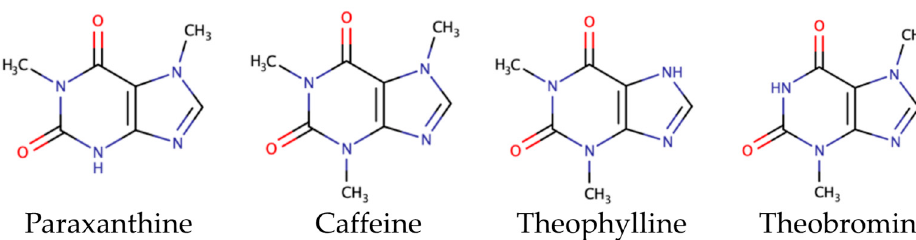
Figure 4. Methylxanthines structures.